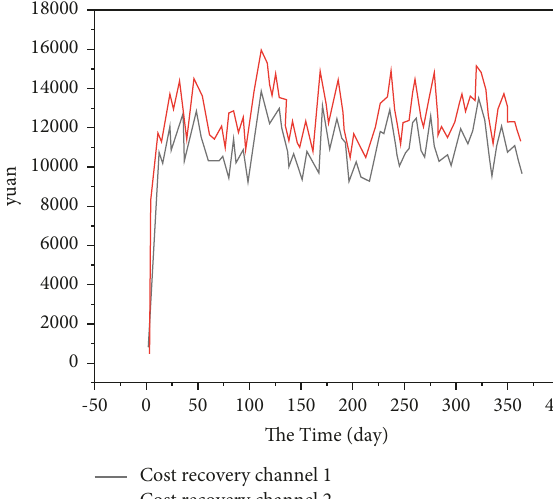
Figure 6: Comparison of the recycling rate of double-channel packaging waste.